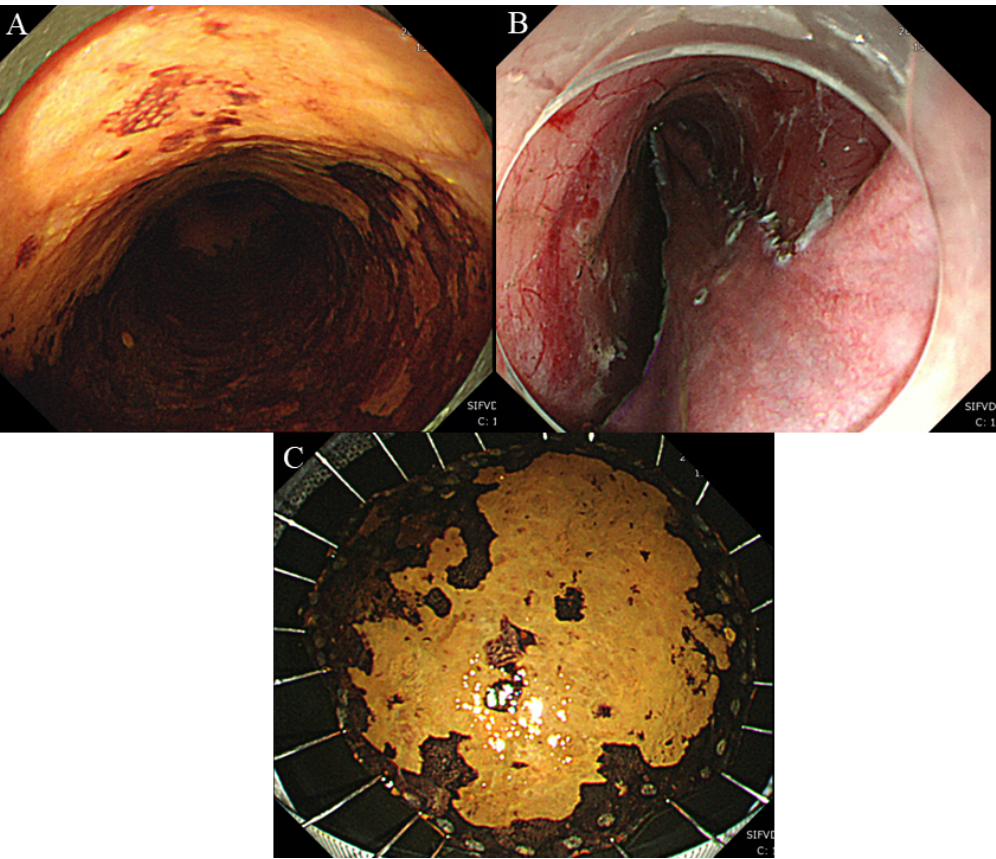
Figure 1. Esophageal endoscopic submucosal dissection (ESD) for superficial esophageal squamous cell carcinoma. ( A ) Widespread superficial esophageal squamous cell carcinoma. ( B ) Post-operative ulcer after ESD. ( C ) Specimen after ESD (size, 50 mm; complete resection).